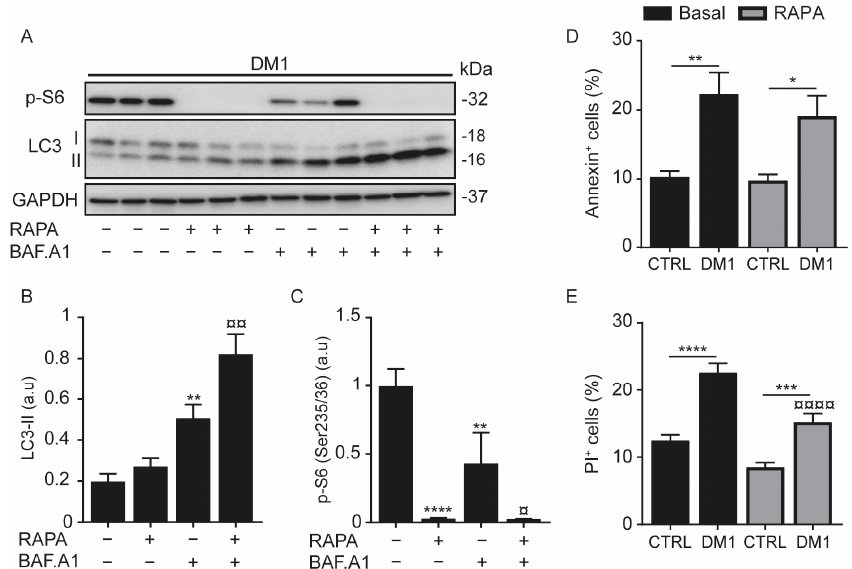
Figure 2. Autophagy and cell death are induced in DM1 fibroblasts. ( A – C ) Fibroblasts from patients with DM1 were treated with 100 nM bafilomycin A1 (BAF.A1) and/or 1 µM rapamycin (RAPA) for 2 h. Protein expression levels of LC3-II ( A , B ) and p -S6 (Ser235/236) ( A , C ) were determined by immunoblotting and their densitometry was normalized to the loading control, GAPDH. Data correspond to the mean ± SD of three independent lines (** p < 0.01, **** p < 0.0001 compared with untreated cells, and ¤ p < 0.05, ¤¤ p < 0.01 versus BAF.A1-treated cells with one-way ANOVA-Tukey’s test), arbitrary units (a.u). ( D , E ) CTRL and DM1 cells were treated with 1 µM RAPA for 24 h and then stained with annexin and propidium iodide (PI). The percentages of annexin-positive ( D ) or PI-positive ( E ) cells were detected by flow cytometry. Data are the mean % ± SEM of three replicates (* p < 0.05, ** p < 0.01, *** p < 0.001, **** p < 0.0001 with respect to CTRL cells and ¤¤¤¤ p < 0.0001 versus DM1 cells with two-way ANOVA-Tukey’s test), N = 10,000 events. Each group (CTRL or DM1) consisted of three cell lines. All experiments were performed at least three times.